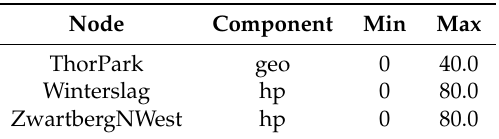
Table 3. Design choices for the nominal power of the central heat generation systems. The power is expressed in MW. The abbreviations “geo” and “hp” stand for geothermal heating plant and air source heat pump,